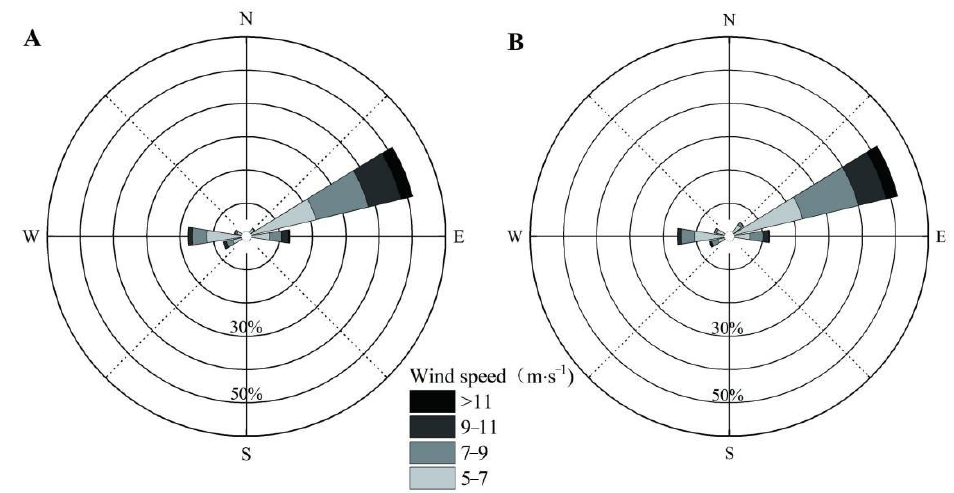
Figure 5. Remote sensing image of the yardangs surrounding the Suoyang City ruins.